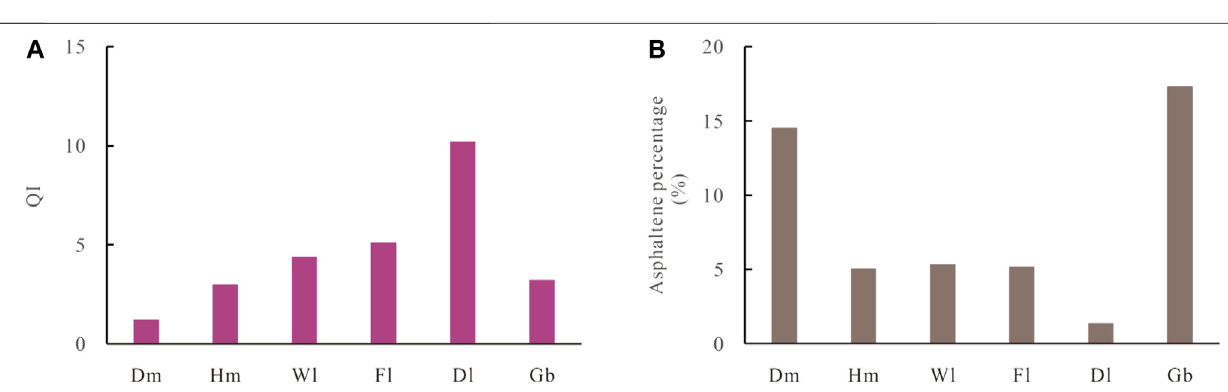
Frontiers in Earth Science |